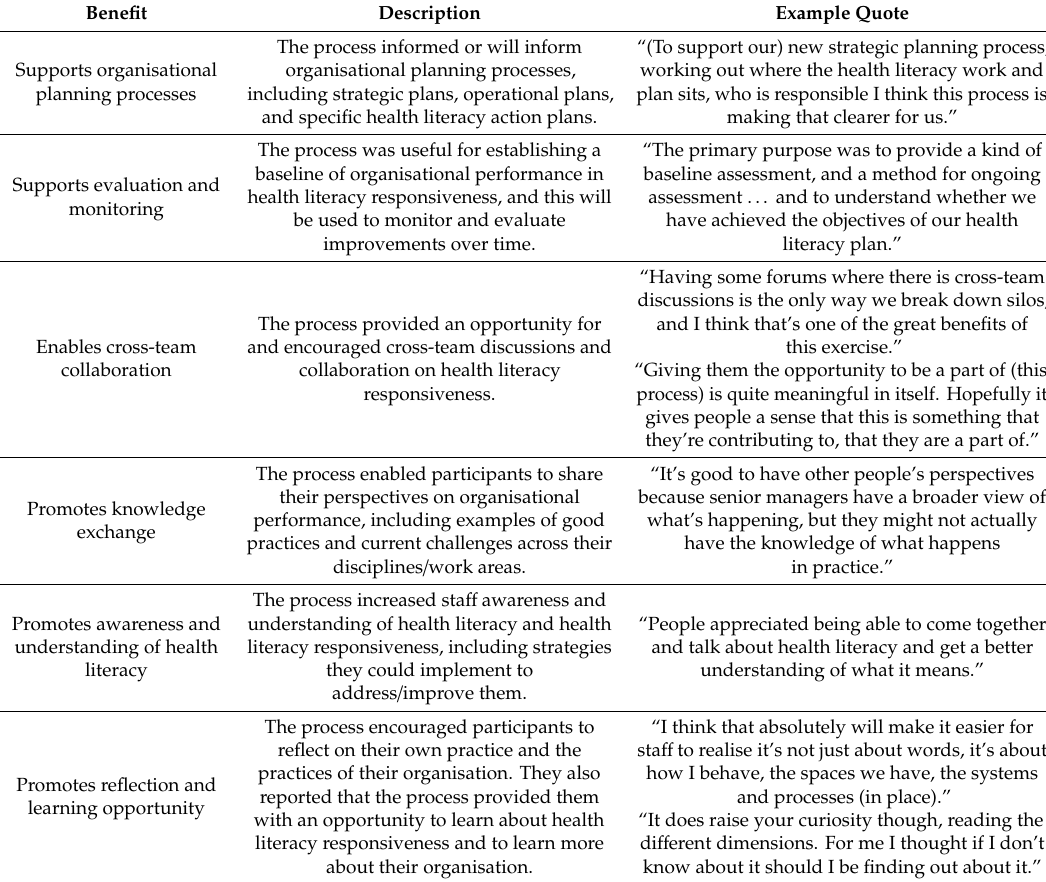
Table 4. Perceived benefits of undertaking the Org-HLR assessment